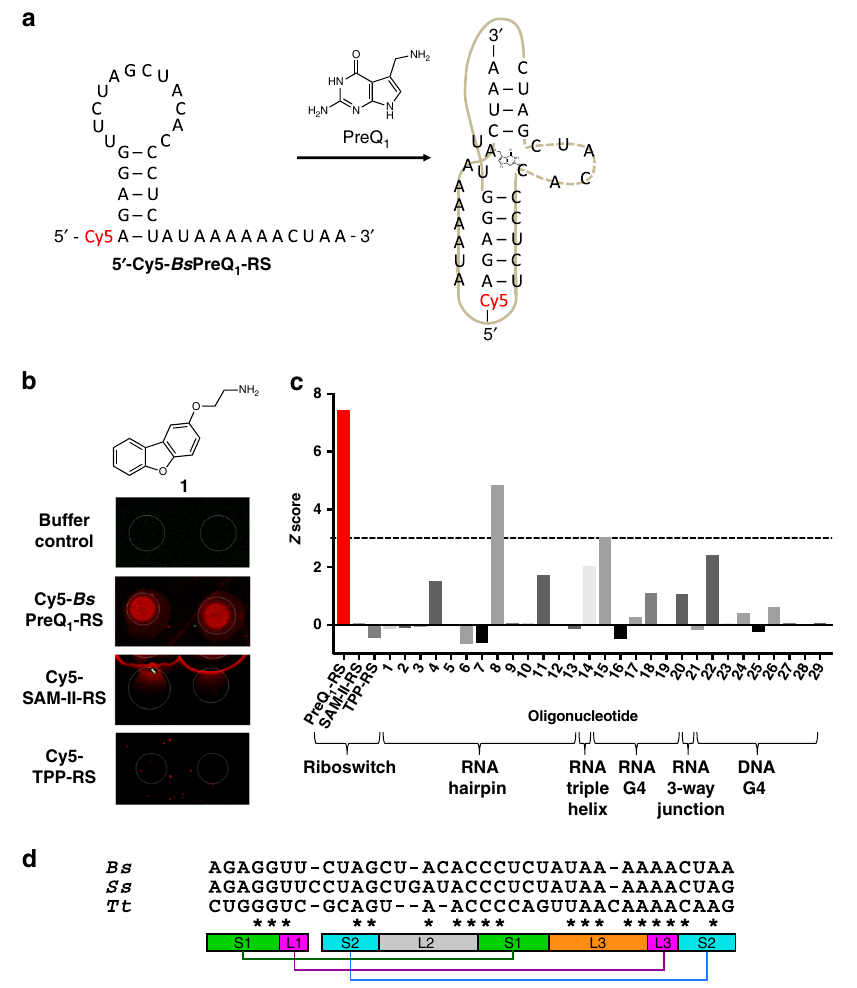
Fig. 1 Small molecule microarray screening. a Sequence of the Cy5-labeled aptamer domain of the Bs PreQ 1 riboswitch (5 ′ -Cy5- Bs PreQ 1 -RS) used for SMM screening. The conformational change induced by PreQ 1 binding is also shown. b SMM images for the hit compound 1 (compound is printed in duplicate). Spot diameter (white circle) is 150 µ m. c Selectivity of the hit compound across various oligonucleotides screened using the SMM platform (Supplementary Table 2) as measured by composite Z-score. Horizontal line corresponds to a “ hit ” cutoff of 3. d Sequence alignment of Bs , Ss , and Tt PreQ 1 riboswitch aptamers. Conserved nucleotides are marked by asterisks. Secondary structure of the class I PreQ 1 riboswitch aptamers is below the alignment and base- pairing interactions are indicated by colored